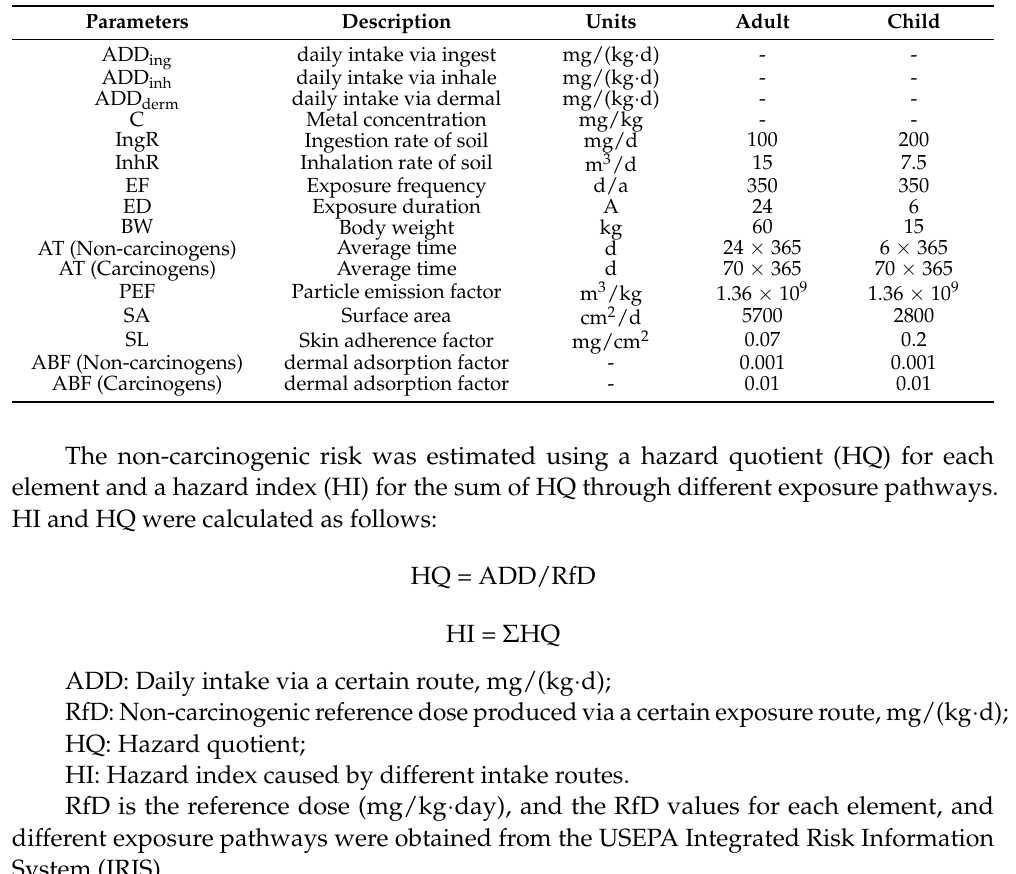
Table 2. Parameter model of soil health risk